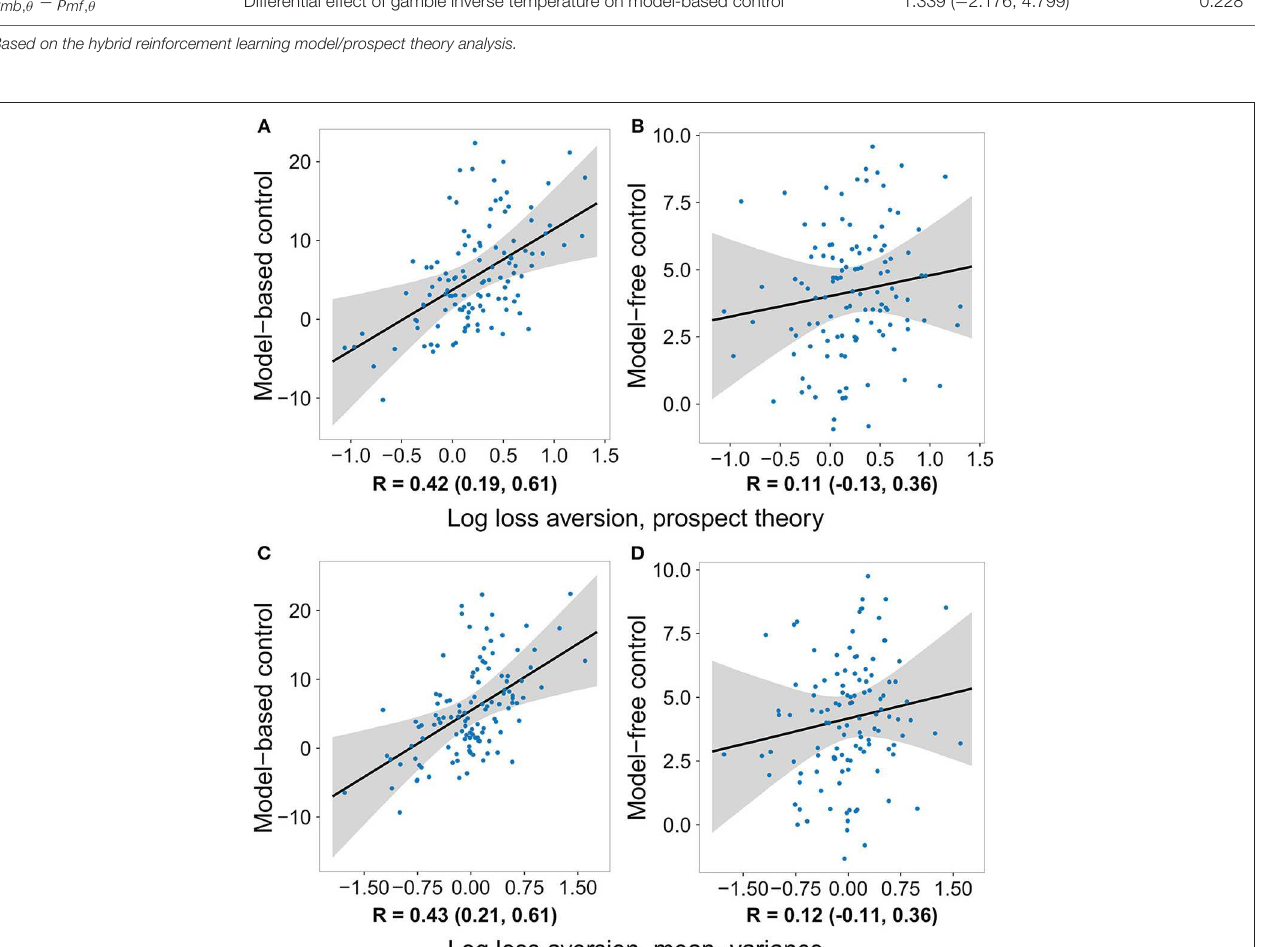
Frontiers in Neuroscience |